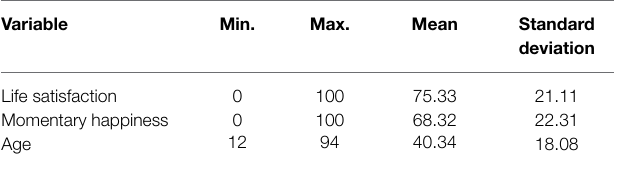
TABLE 2 | Statistics for the three metric variables life satisfaction, momentary happiness, and age.